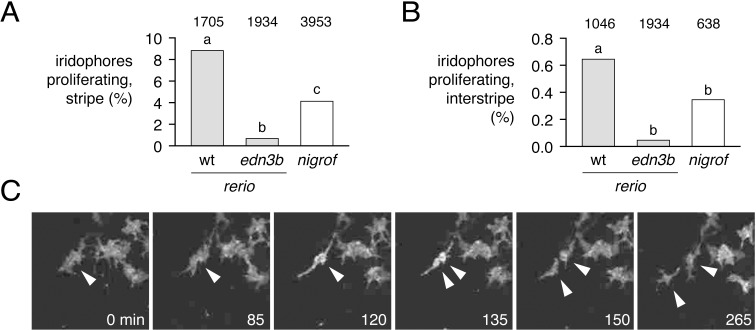
Reduced iridophore proliferation in edn3b mutant D. rerio and D. nigrofasciatus.(A) Among loosely organized iridophores of prospective stripe regions, the percent of individual cells dividing during time-lapse imaging (15 h total duration) was greatest in edn3/+ (wt) D. rerio and markedly reduced in sibling edn3b mutant D. rerio as well as D. nigrofasciatus (logistic regression: genotype, χ2 = 77.5, d.f. = 2, P<0.0001; SL, χ2 = 77.6, d.f. = 1, P<0.0001). (B) These same trends were evident for densely arranged iridophores of interstripes, though proliferation overall was reduced in comparison to stripe iridophores (genotype, χ2 = 13.7, d.f. = 1, P<0.005; SL, χ2 = 31.9 d.f. = 1 P<0.0001). Values above bars indicate total numbers of iridophores examined. Preliminary analysis did not reveal significant variation among individual larvae, the cells of which were pooled for final analyses (larval numbers: 8 edn3/+ D. rerio; 8 edn3b mutant D. rerio; 9 D. nigrofasciatus). Different letters above bars indicate genotypes that differed significantly from one another in pairwise comparisons of odds ratios (all P<0.005). (C) Stills from time-lapse video illustrating a single iridophore (arrowhead) within a prospective stripe region that partially rounds up by 120 min and then divides.